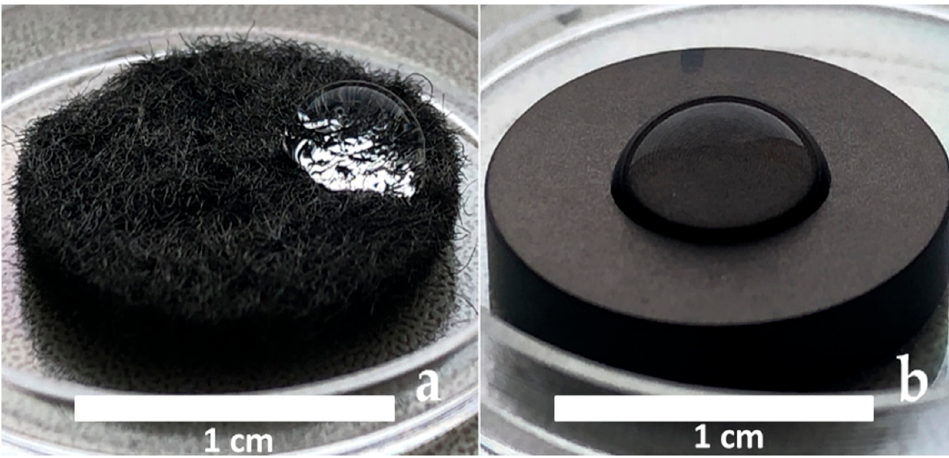
Figure 1. СС M ( a ) and CFR-PEEK ( b ) samples with 50 µL bacterial